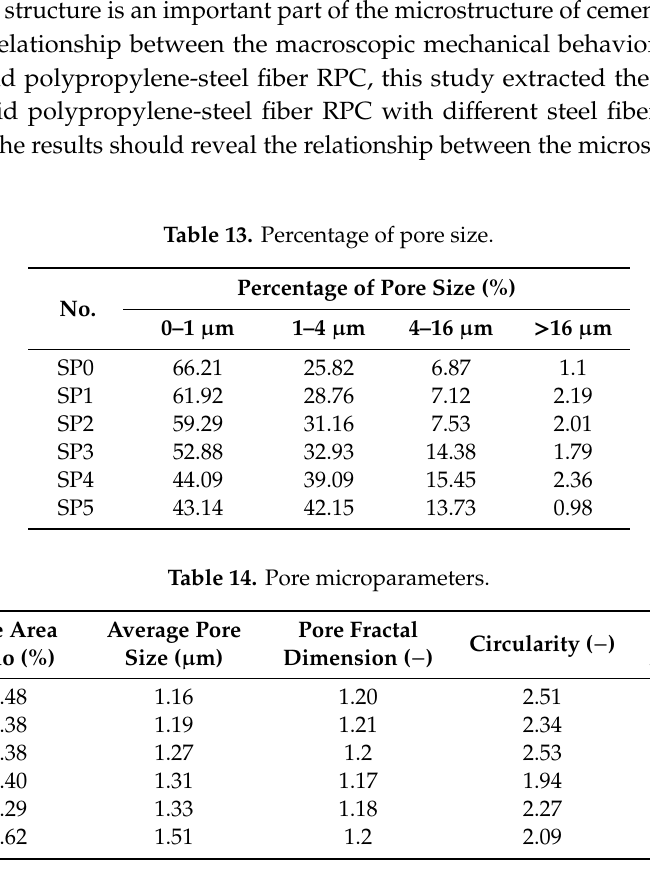
Figure 19. Microparticle parameter.